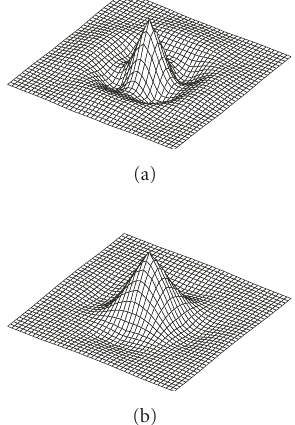
Figure 10: The (a) primal wavelet and (b) primal scaling functions for OPT1.